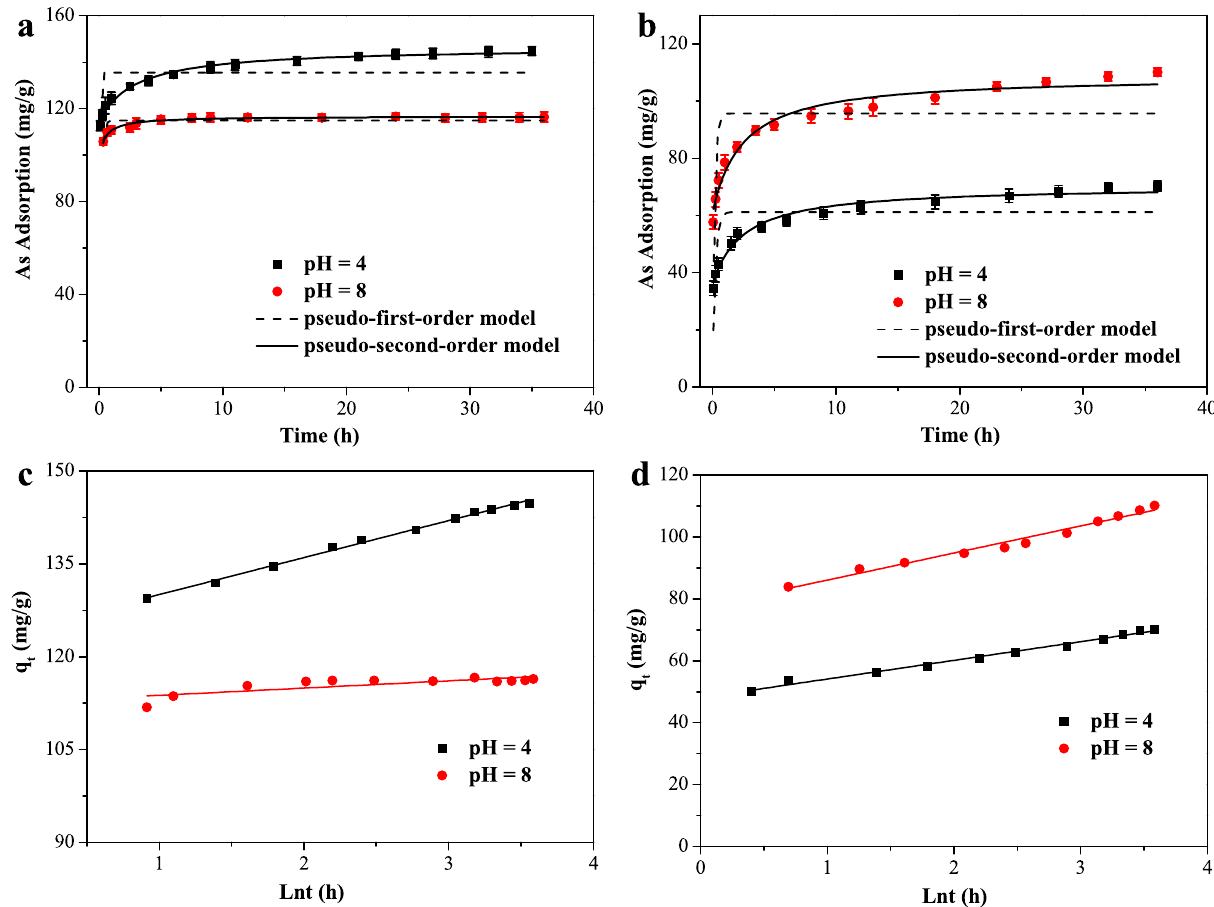
Figure 3. Adsorption kinetics of As(V) ( a ) and As(III) ( b ) adsorption and kinetics plot of pseudo-first-order model and pseudo-second-order model at pH 4.0 and 8.0 with initial As concentrations of 75 mg/L and dosage of 0.5 g/L. Elovich model of adsorption kinetics of As(V) ( c ) and As(III) ( d